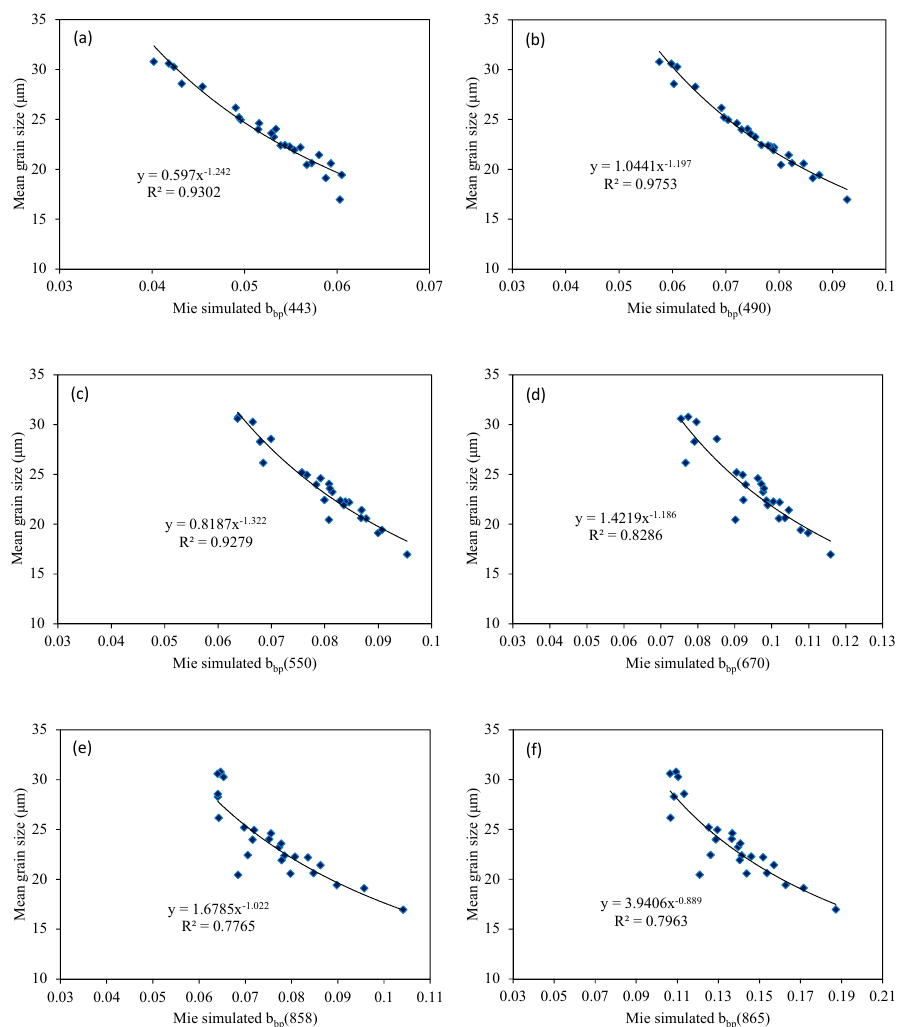
Figure 4. Relationship between the average suspended particle size and the backscattering coefficient estimated by Mie scattering.